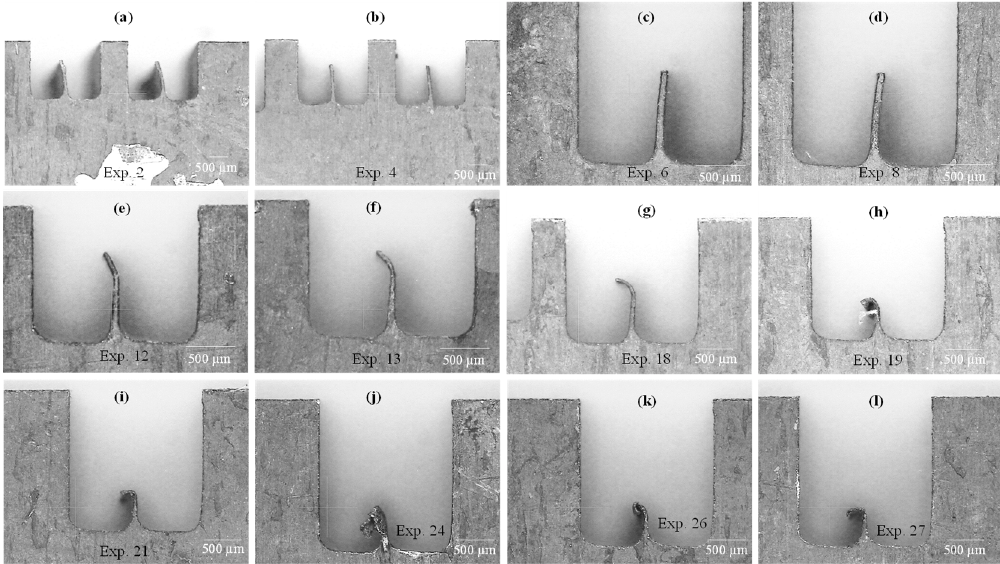
Figure 7. Micro-channels produced under different experimental runs of Taguchi L27.